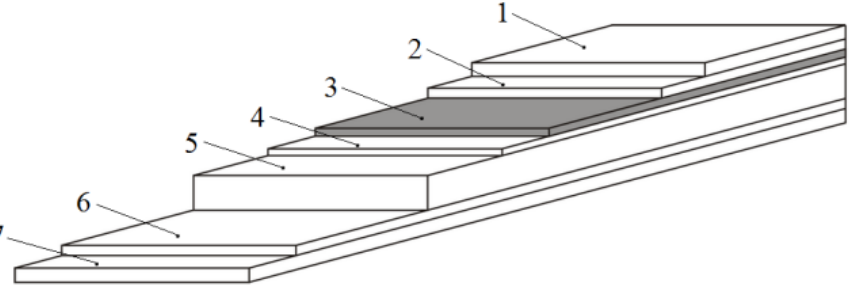
Table 2. Winding parameters.